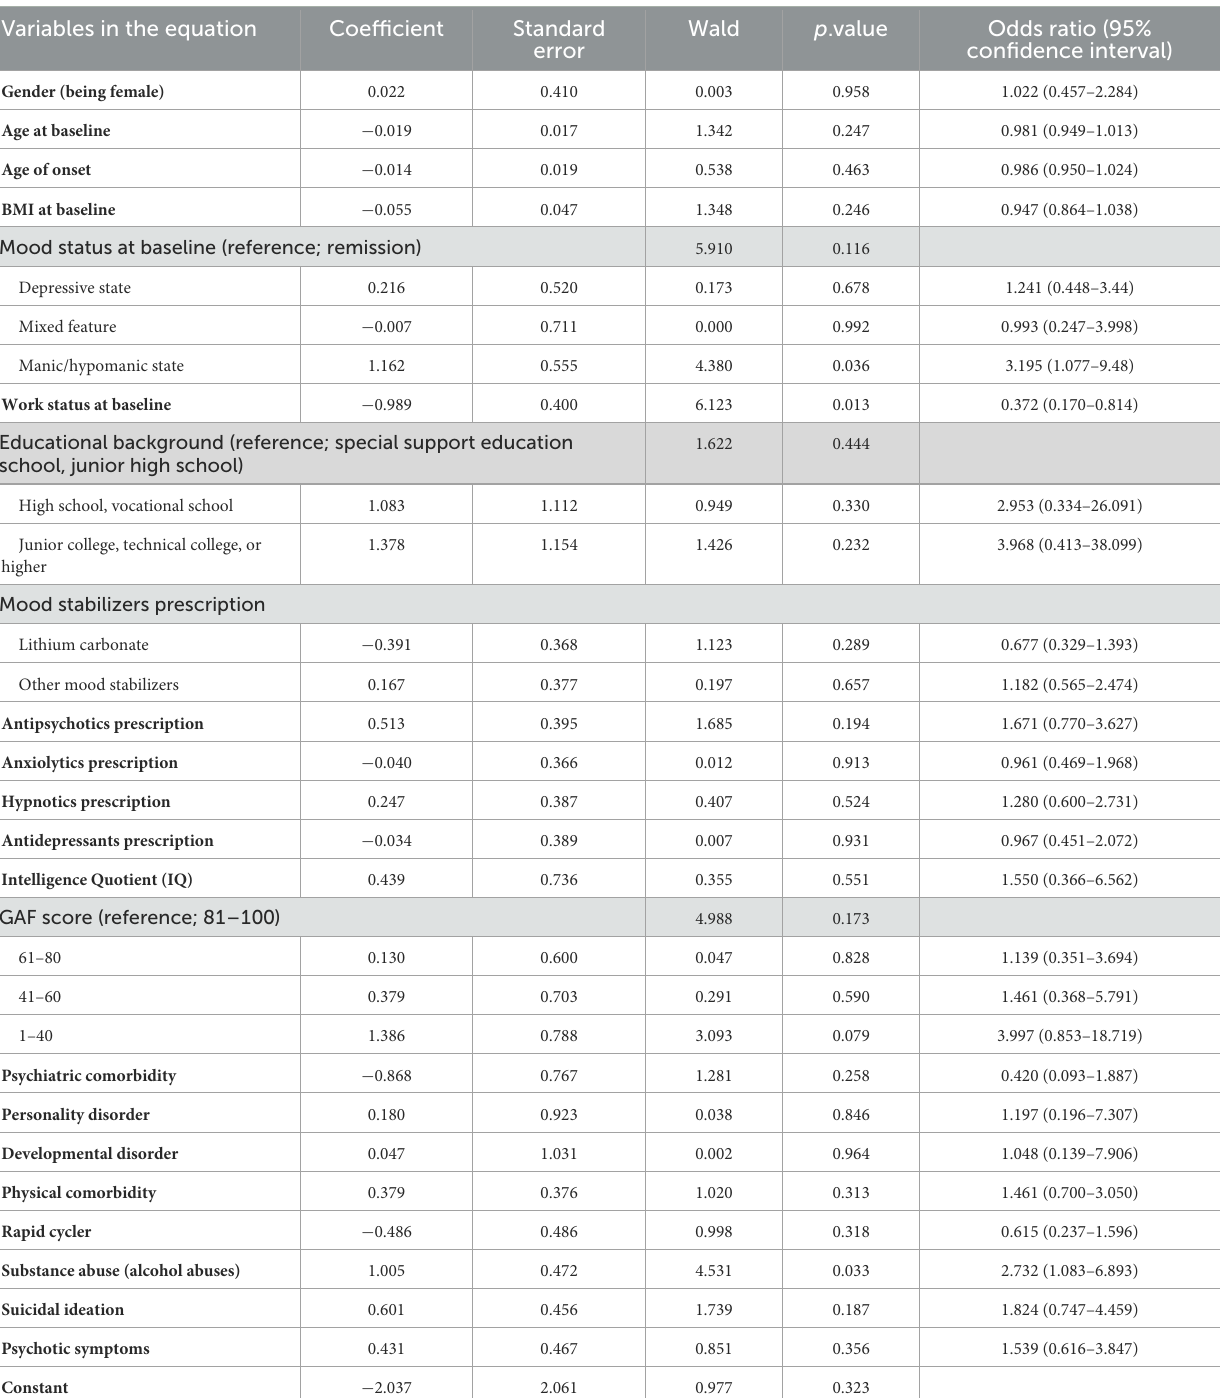
TABLE 4 Binomial logistic regression analysis of factors for psychiatric hospitalization among patients with bipolar I